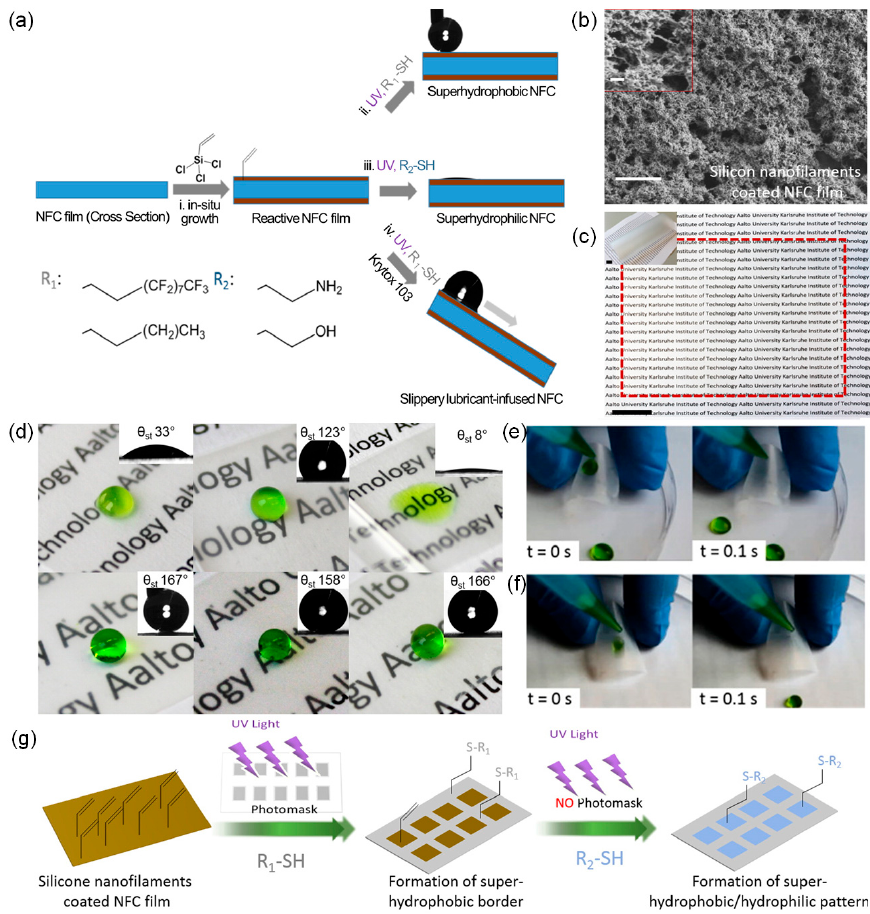
Figure 15. ( a ) Schematic illustration of the functionalization of films of nano-fibrillated cellulose (NFC): ( i ) The NFC film surface was used as a substrate for growing silicone filaments (SNFs) carrying reactive vinyl groups (TCVS-SNFs); ( ii , iii ) The vinyl groups can be reacted with thiolated compounds via photoinduced thiol-ene click reaction. For instance, the reactions can introduce hydrophobic or hydrophilic groups to impart superhydrophobicity or superhydrophilicity, respectively; ( iv ) Slippery liquid-infused porous NFC film surfaces (SLI-NFC) can be fabricated by impregnation of porous NFC films that have been fluorinated by the thiol-ene reaction with a lubricant that is both low in surface energy and chemically inert. ( b ) SEM image revealing the surface topography of an NFC film after growing TCVS-SNFs on the surface. ( c ) A photograph of a printed A4 paper sheet covered with an NFC film to illustrate its transparency and flexibility (inset). ( d ) Dyed water droplets deposited on the surface of NFC films with different modifications. Upper frames from left to right: NFC film, NFC film covered with reactive TCVS-silicone nanofilaments, and hydrophilic NFC film with cystemine functionalization. Lower frame from left to right: fluorinated NFC film, fluorinated NFC film (back side), and alkylated NFC film. ( e ) Bent NFC films. ( f ) Schematic illustration of the formation of superhydrophobic-superhydrophilic patterns on a TCVS-NFXC film by the thiol-ene reaction. Reproduced from [111] with permission; Copyright Wiley